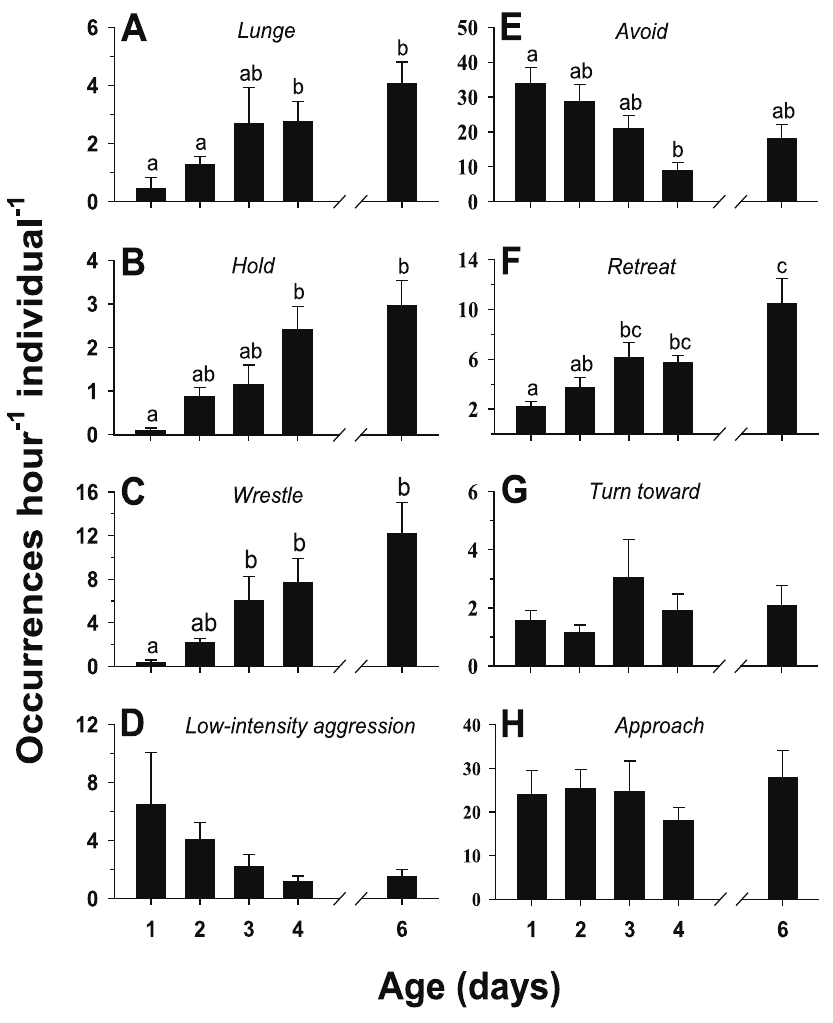
Figure 5. Ontogeny of interactive behaviors. Changes in the frequency of occurrence of interactive behaviors (see Table 1 for descriptions) in socially naı¨ve, male flesh flies with respect to adult age, in days. Two individually isolated, same-age males were placed in a simple arena and the resulting behaviors were monitored for each fly. Frequencies were calculated as the number of occurrences hour 2 1 individual 2 1 for each of the following behaviors: (A) lunge , (B) hold , (C) wrestle , (D) low-intensity aggression , (E) avoid , (F) retreat , (G) turn toward , and (H) approach . Vertical bars indicate means 6 s.e.m. Different letters above the bars indicate significant differences.